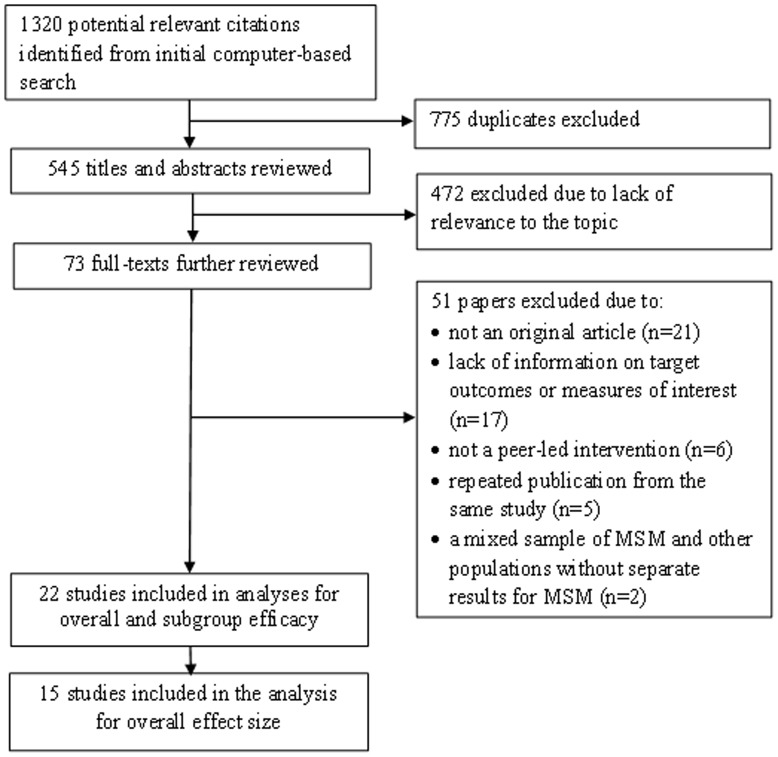
Flowchart of literature search and selection of studies.